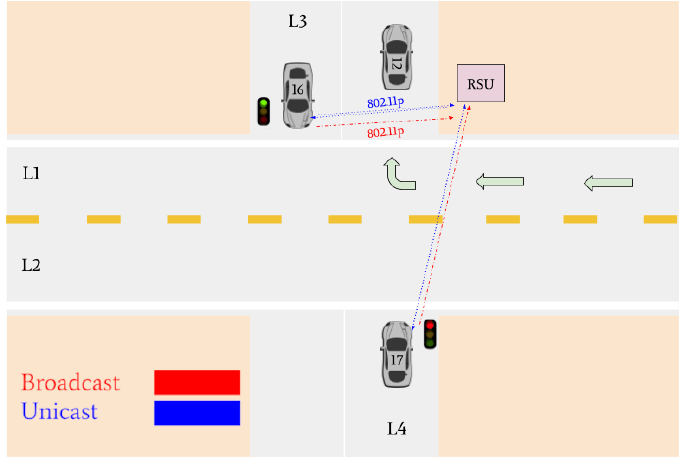
Figure 19. Vehicle 11 turns left. Vehicles 12, 16, and 17 declare their intentions to the RSU. The RSU issues a green light to Vehicle 12 and red lights to Vehicles 16 and 17.